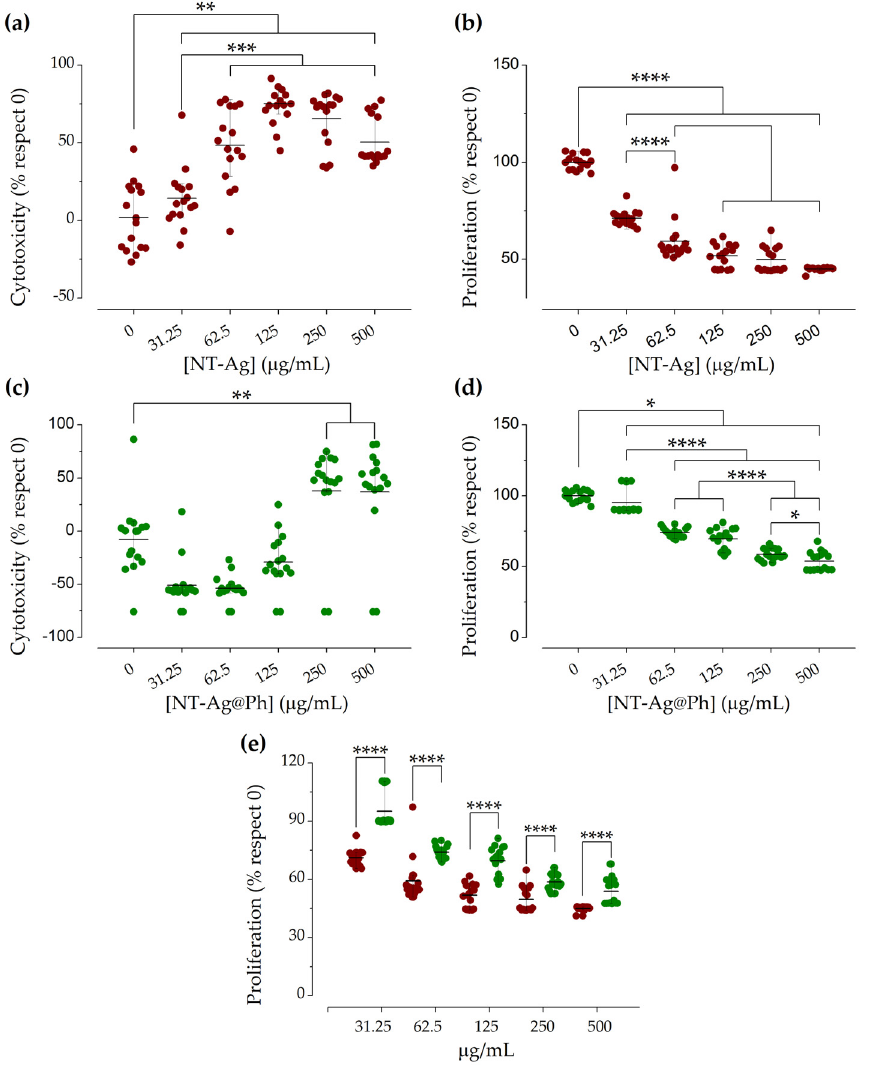
Figure 7. Cytotoxicity of NT-Ag ( a ) and NT-Ag@Ph ( c ), and fibroblastic proliferation of NT-Ag ( b ) and NT-Ag@Ph ( d ). Comparative proliferation ( e ) of unloaded (garnet) and loaded (green) material with phenytoin sodium. *, **, ***, **** p < 0.05, 0.01, 0.001, and 0.0001 for Mann–Whitney and Krus- kal–Wallis